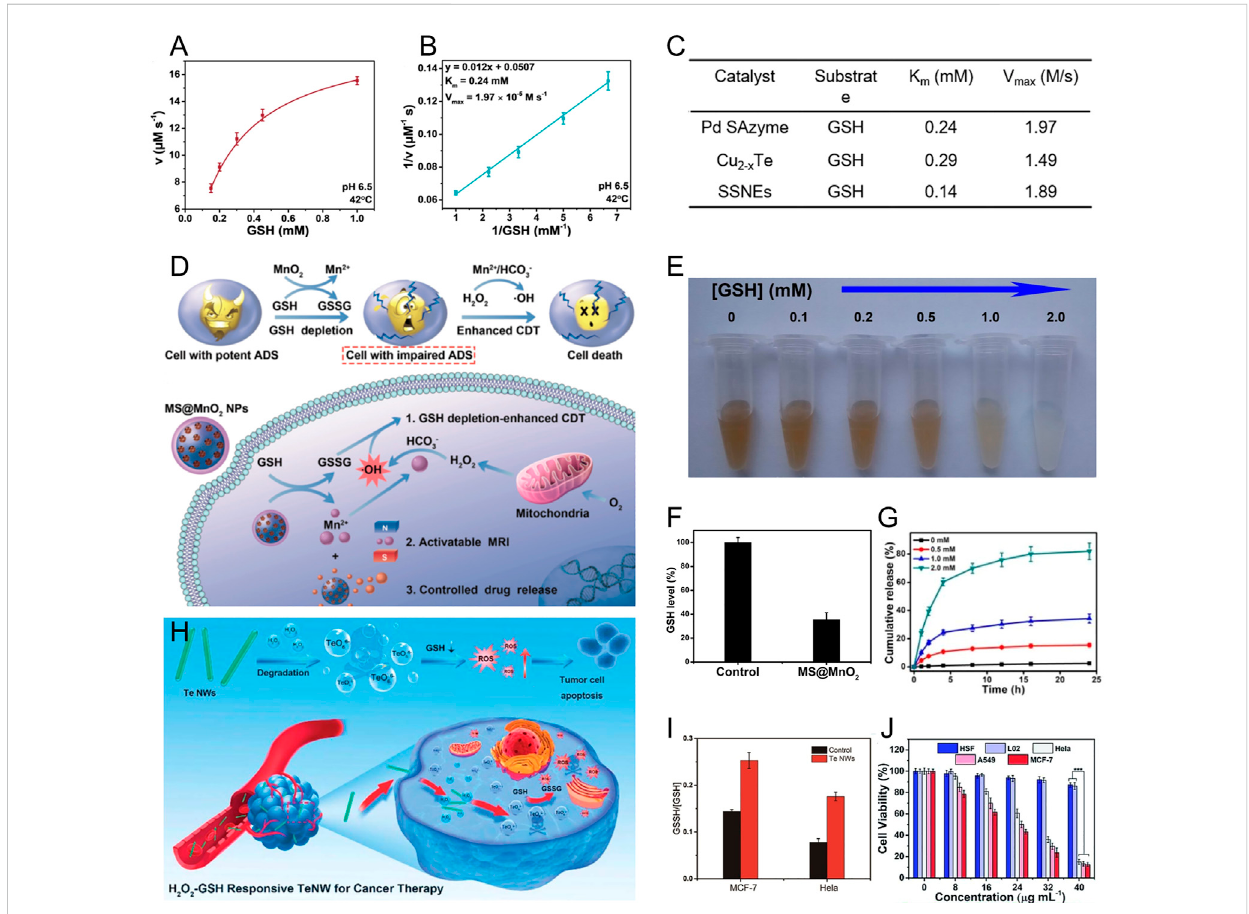
FIGURE 1 (A) Michaelis-Menten kinetics and (B) Lineweaver-Burk curves for Pd SAzyme with GSH as a substrate. (C) The K m and V max of as prepared Pd SAzyme,Cu 2-x Te,andSSNEswithGSHasthesubstrateforGSHperoxidasecatalysis.Reproducedwithpermission.Copyright2021JohnWiley&Sons. (D) The mechanism of MnO 2 for Fenton metal ion delivery and GSH exhaustion. (E) Photo of MnO 2 -MSNs after incubating with different concentrations of GSH. (F) The GSH level of U87MG cells after the incubation with MnO 2 -MSNs. (G) Release behavior of CPT from GSH-treated MnO 2